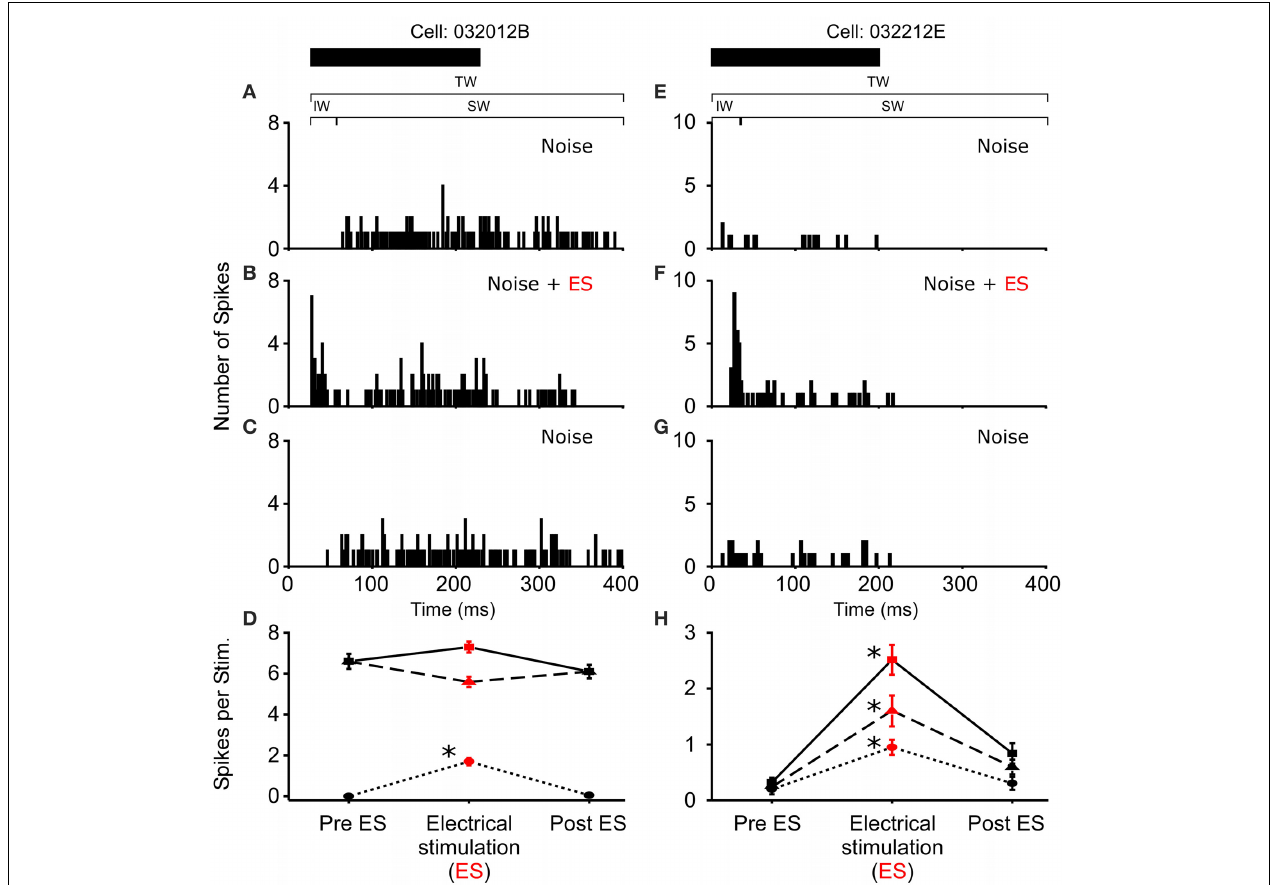
FIGURE 3 | Increased excitability due to sound-by-sound electrical stimulation. (A–C) Example cell showing increased auditory excitability in the initial window (IW) when acoustic stimuli are coupled with electrical stimulation of the thalamus. The spike train changes from a tonic responses to a primary like response. (E–G) Example cell in which